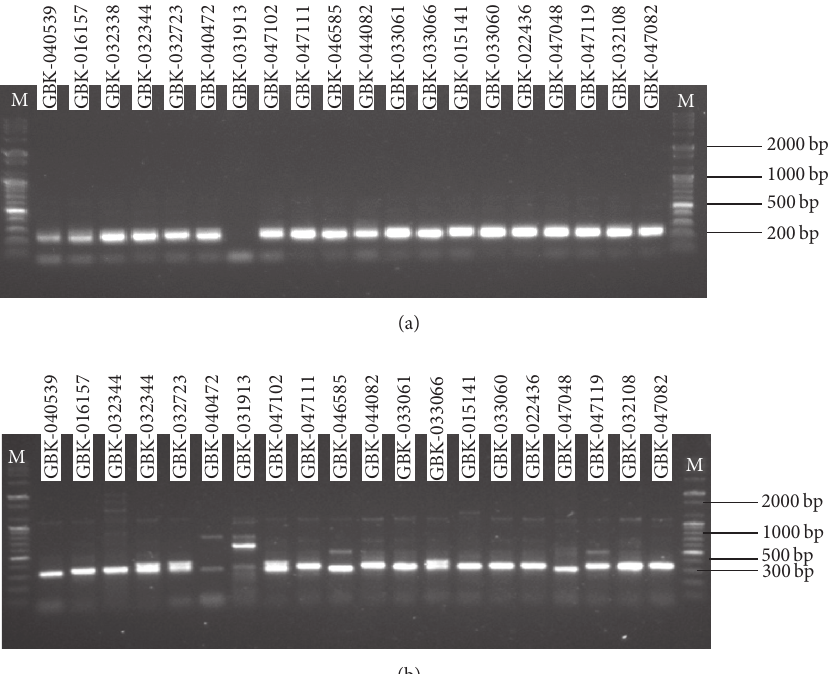
Figure 1: (a) PCR products of the 20 accessions of cowpea amplified using SSR primer 6652: M indicates the ladder. (b) PCR products of the 20 accessions of cowpea amplified using SSR primer 6540: M indicates the